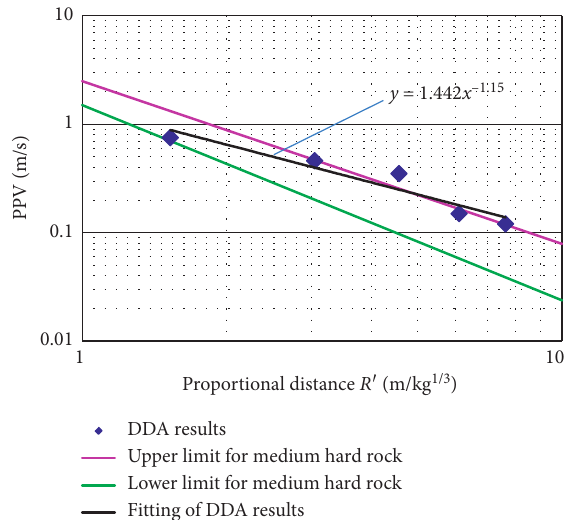
Figure 10: Attenuation curve of PPV .